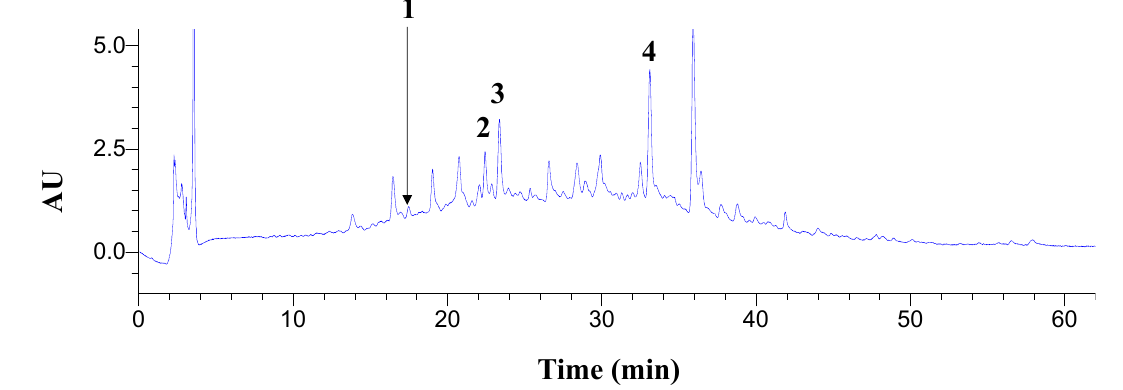
Figure 5. Chromatogram of PP extract obtained with HP- β -CD, under optimized conditions, at 30 °C. The trace was recorded at 325 nm. Peak assignment: 1, neochlorogenic acid; 2, chlorogenic acid; 3, caffeic acid; 4, ferulic acid.